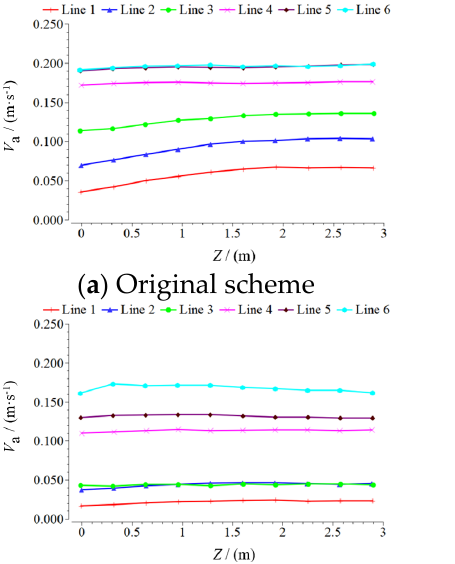
Figure 15. Diagram of axial velocity on the inlet of the sump 3#.